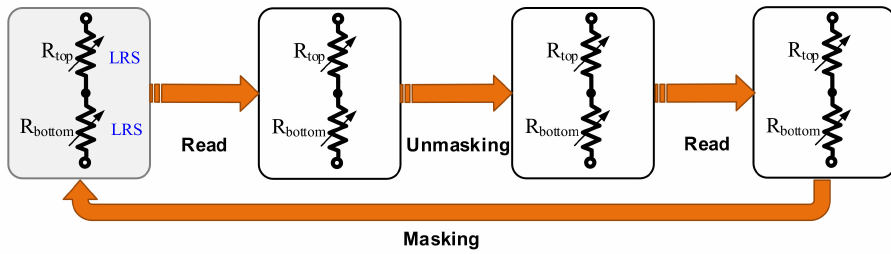
Figure 10. Diagram of operations and state transformation to reproduce the results in